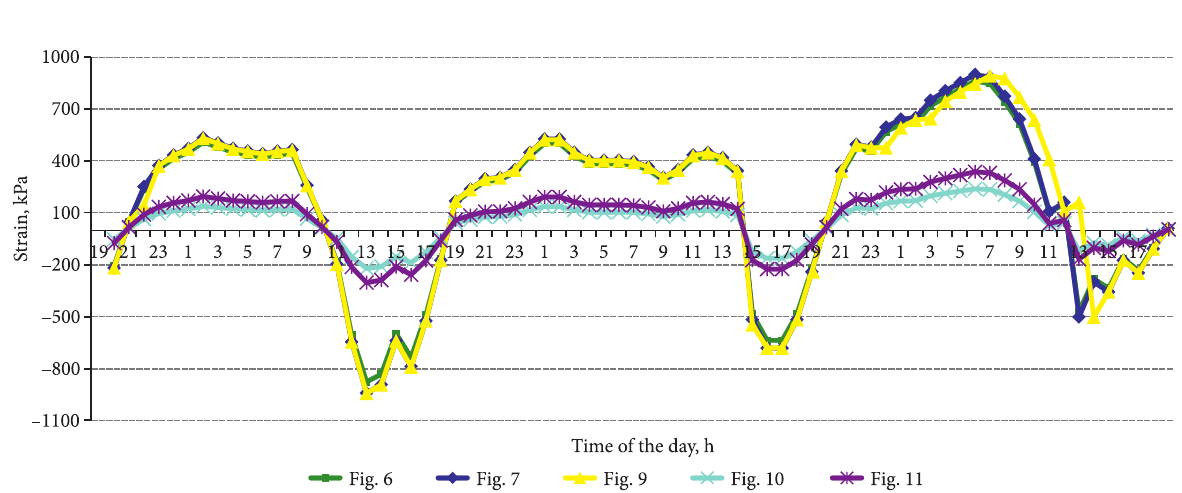
Fig. 20. Mode of deformation for the upper asphalt concrete layer – stresses during the days with max positive temperatures (schemes in Figs 6, 7,